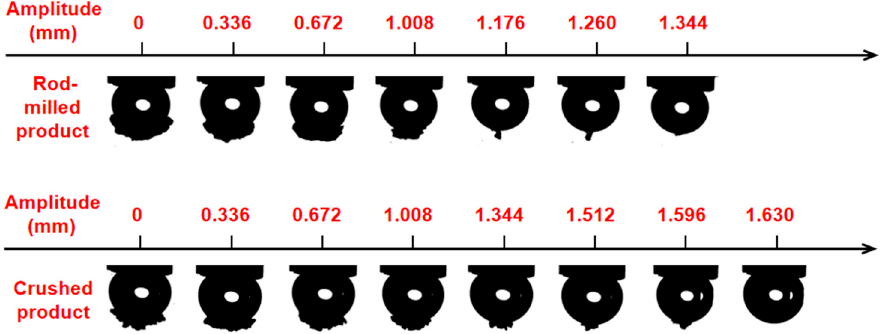
Figure 9. Bubble-particle detachment behavior of different comminution products.